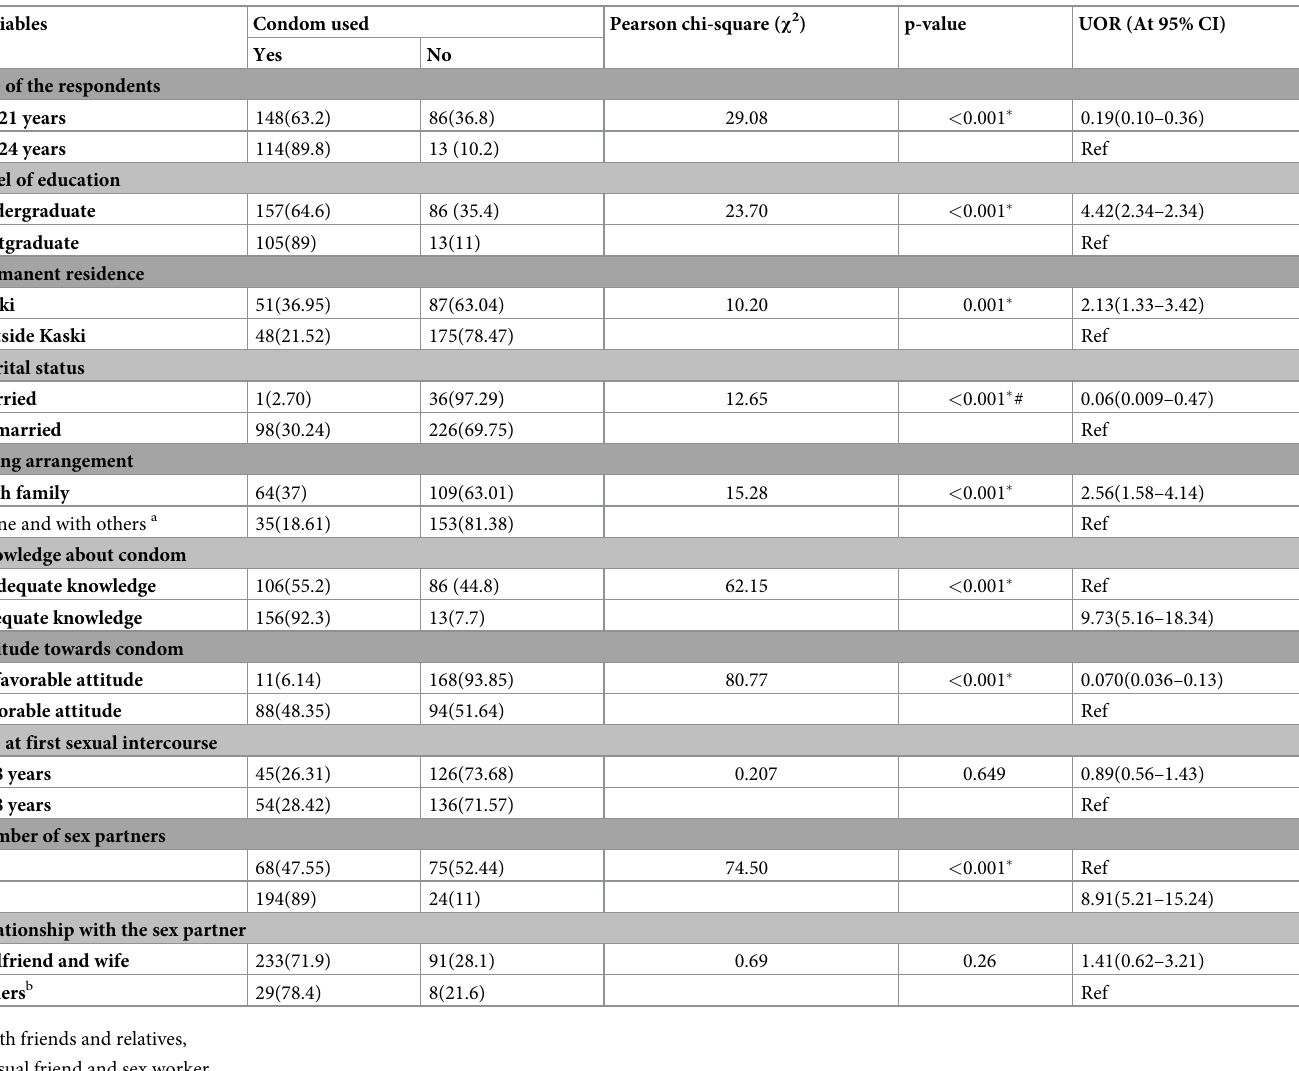
Table 6. Association of different variables with condom use during the last sexual intercourse among the youth (n = 361).